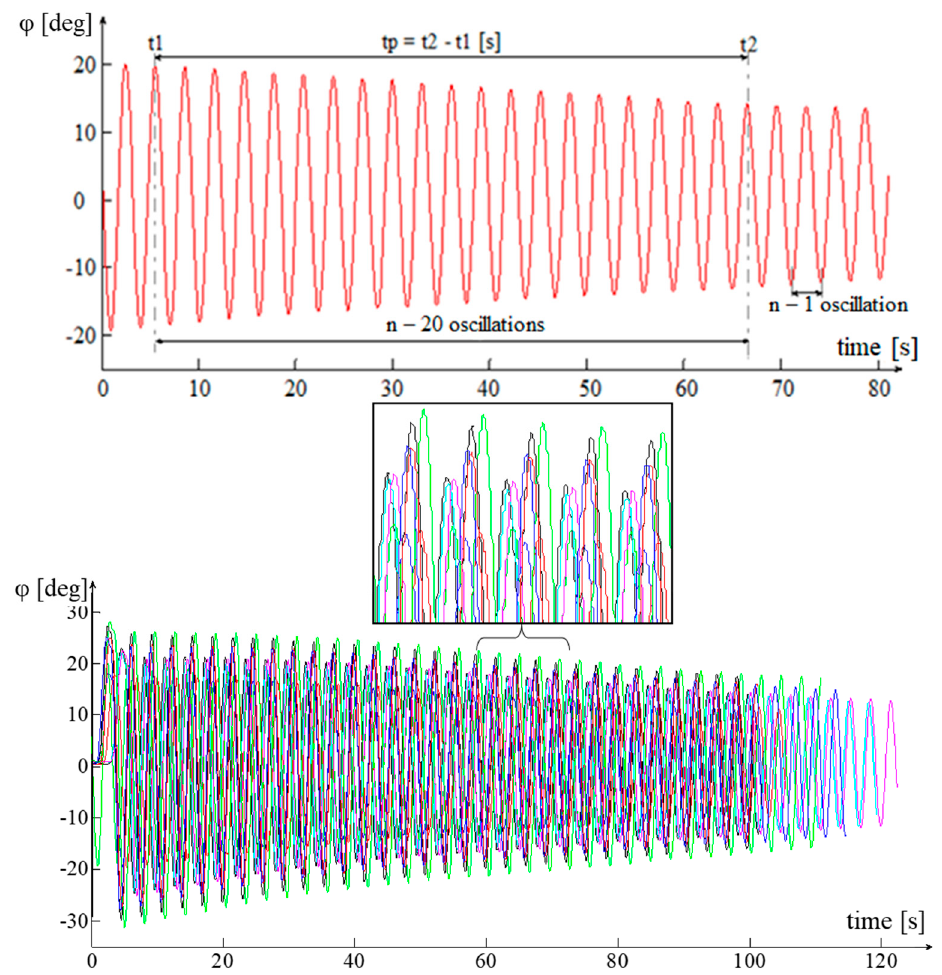
Figure 26. Graphical representation of the experimental data and the algorithm for extracting the data necessary to determine the period of oscillation, the red sample is their average, and each color represents the samples in Table 6.